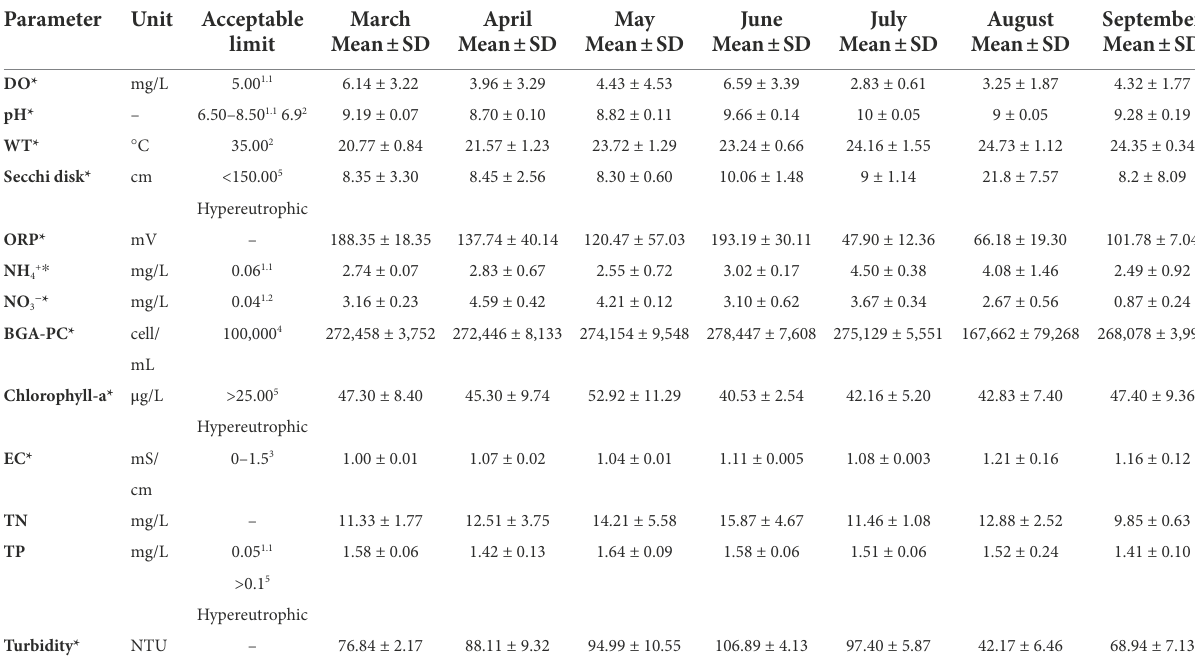
TABLE 1 Water physicochemical features of Lake Cajititlán between March and September of